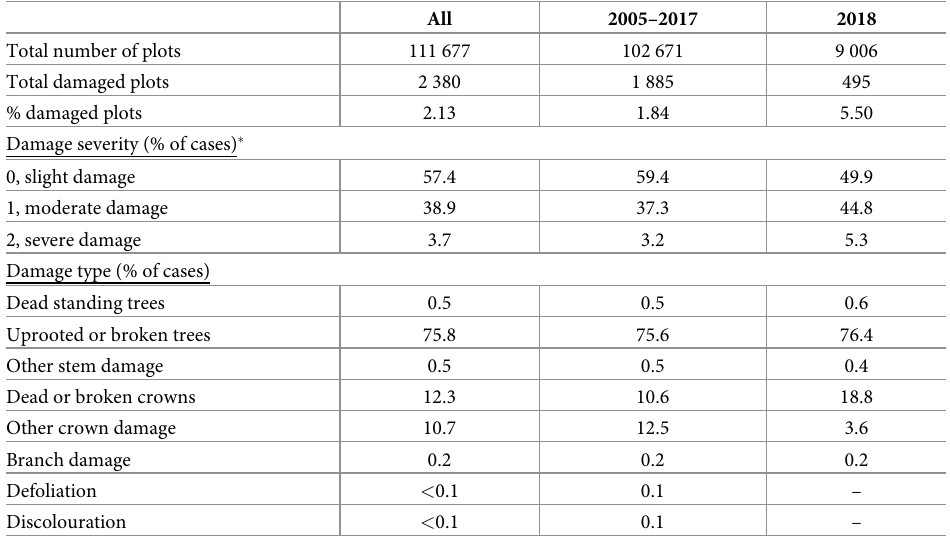
Table 1. Statistics of stand level snow damage, damage severity and damage type in the NFI data. The values are also shown separately for 2005–2017 with typical snow conditions and year 2018 with exceptionally high snow